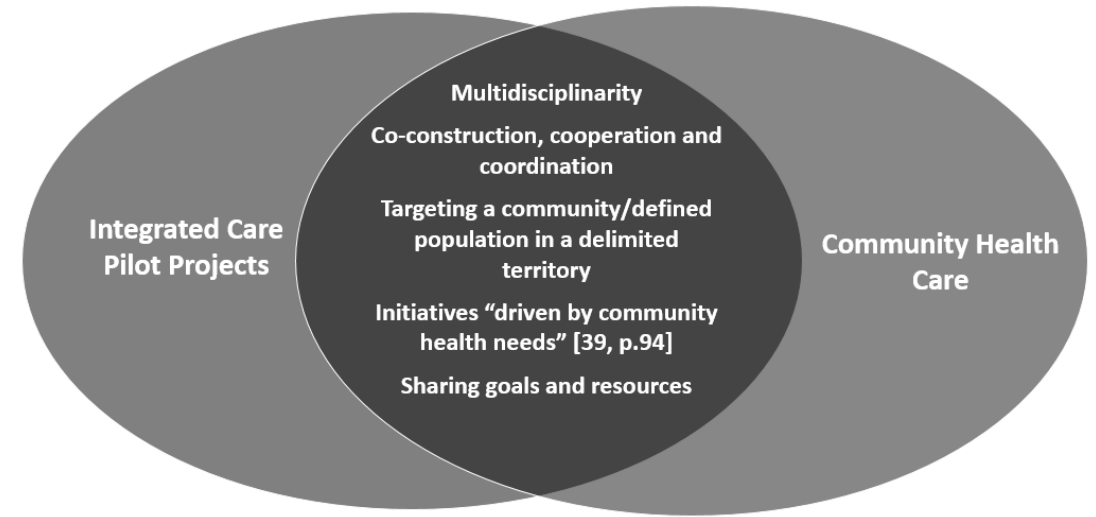
Figure 2. Community health characteristics.